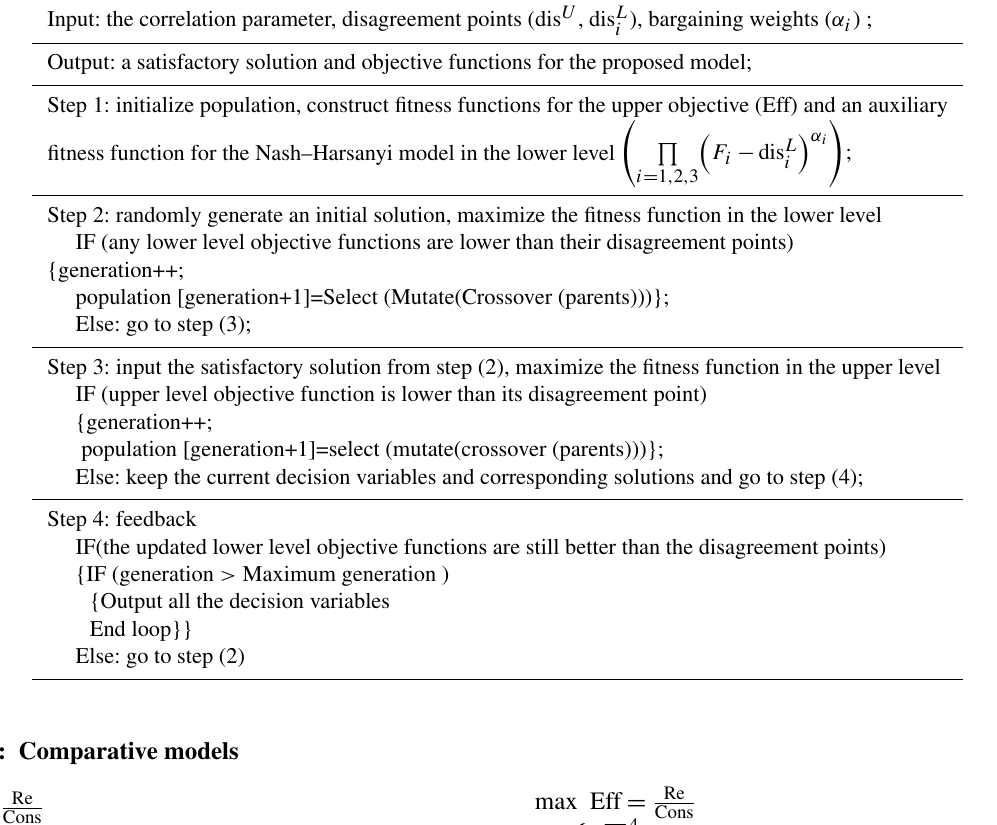
Table B1. Pseudo code for the proposed